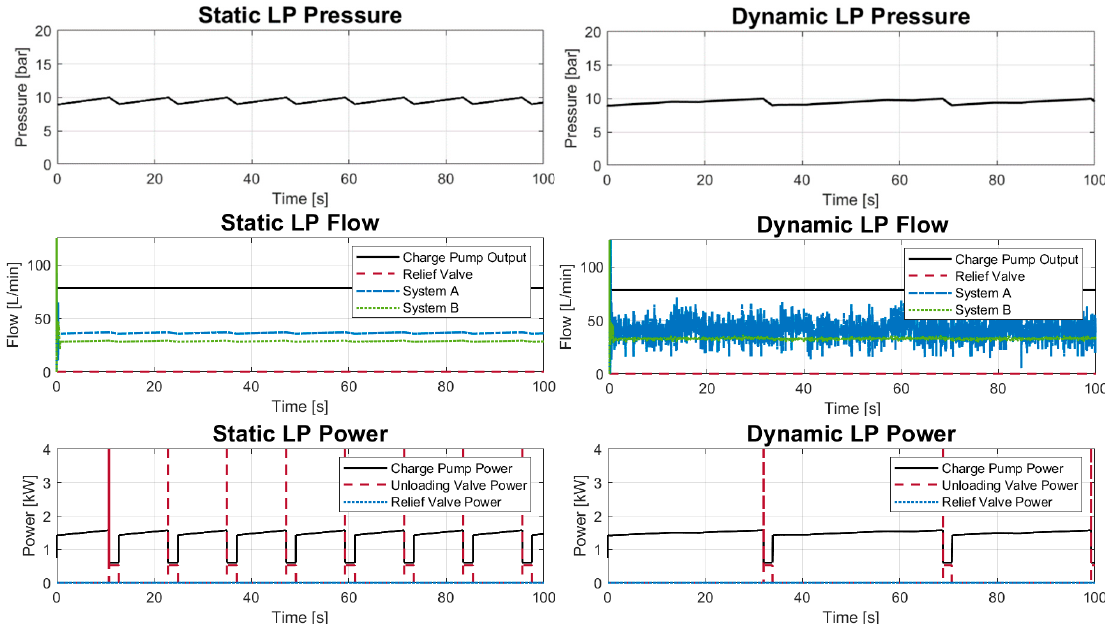
Figure 15. 10% ASPU valve with split LP system results for static and dynamic operating conditions.